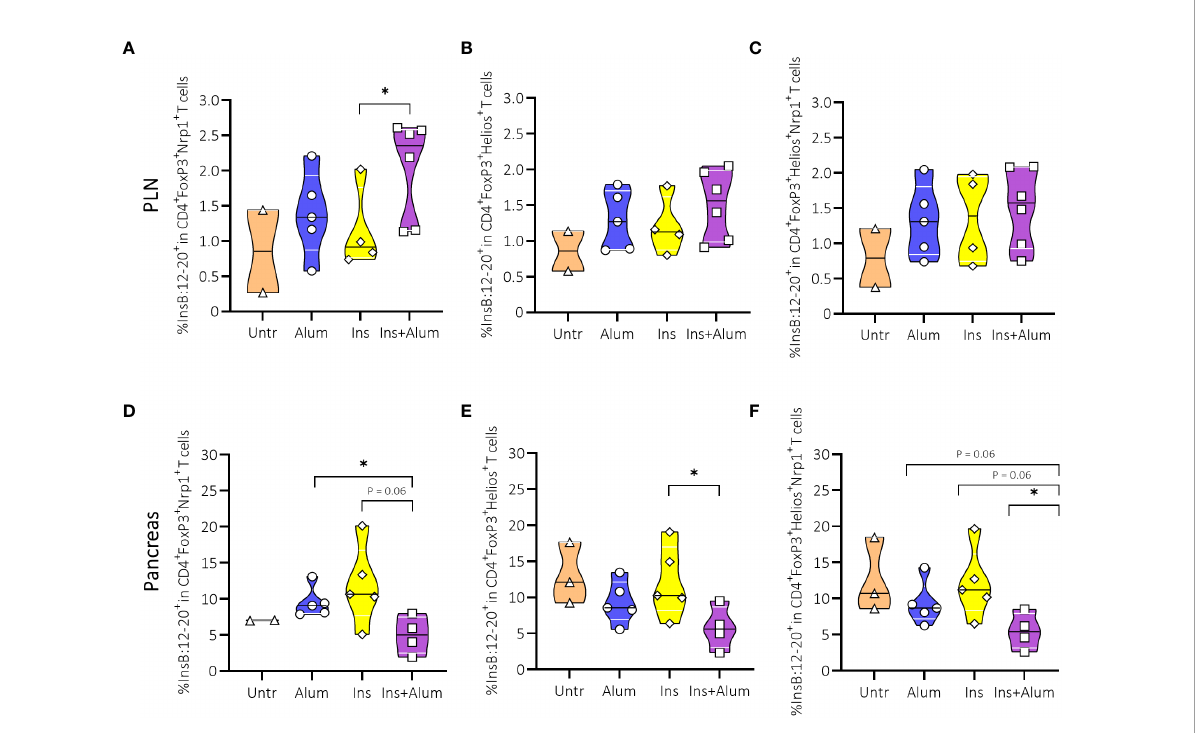
FIGURE 7 Effect of insulin therapy on InsB:12-20-reactive Helios- and/or Neuropilin-1 (Nrp-1)-expressing Foxp3 + Tregs. Frequencies of InsB:12-20- reactive cells within the CD4 + FoxP3 + Nrp1 + T cell population (A, D) , CD4 + FoxP3 + Helios + T cell population (B, E) , and CD4 + FoxP3 + Helios + Nrp1 + T cell population (C, F) are shown at 15 weeks of age in PLN and pancreas of NOD mice. Female NOD mice received four weekly subcutaneous injections, from 10 until 13 weeks of age, of InsB:8-24 peptide formulated in alum (Ins+alum), InsB:8-24 peptide dissolved in buffer (Ins), alum alone (alum), or left untreated (Untr). Data presented as median with interquartile range; symbols (n = 2-6) represent individual mice. *P ≤ 0.05; Treg, regulatory T cell; NOD, non-obese diabetic; PLN, pancreas-draining lymph